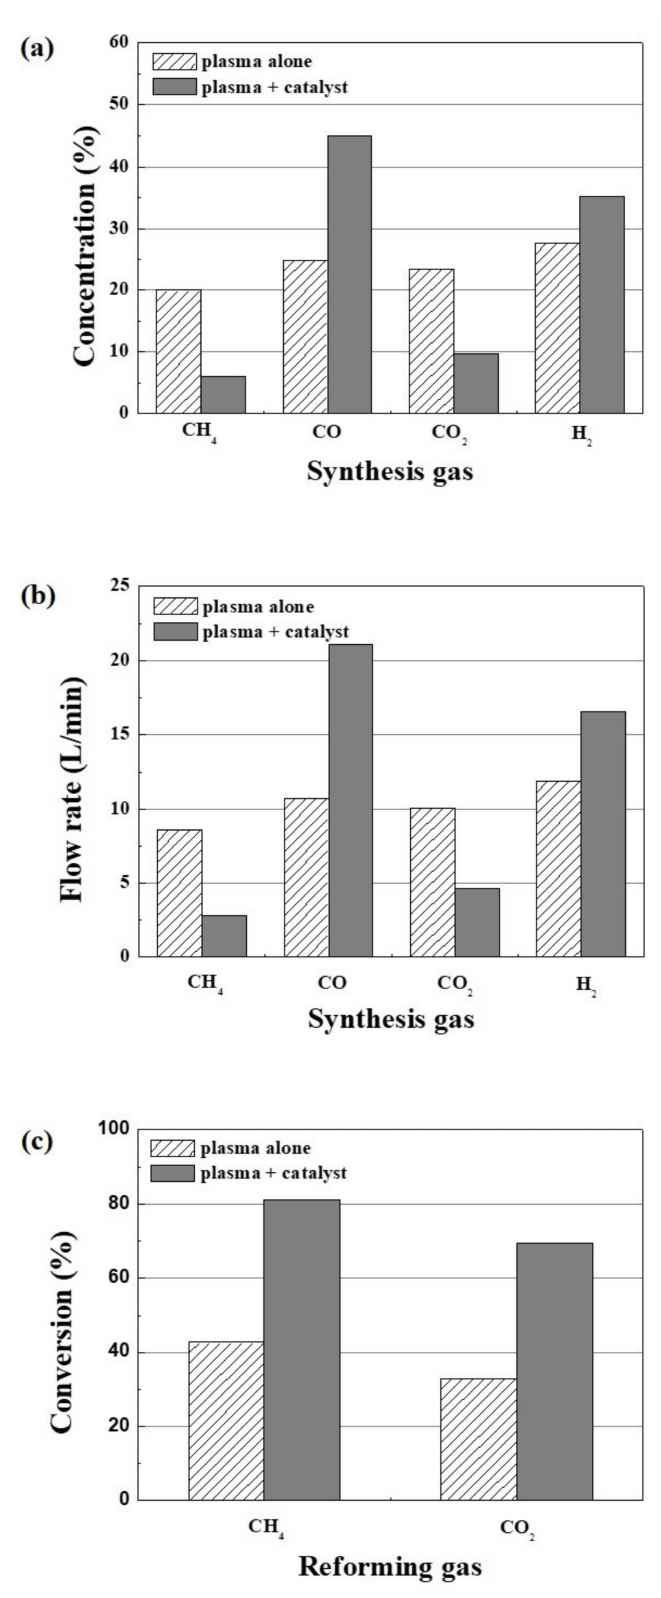
Figure 6. ( a ) Concentration, ( b ) flow rate, and ( c ) conversion ratio obtained with di ff erent reforming